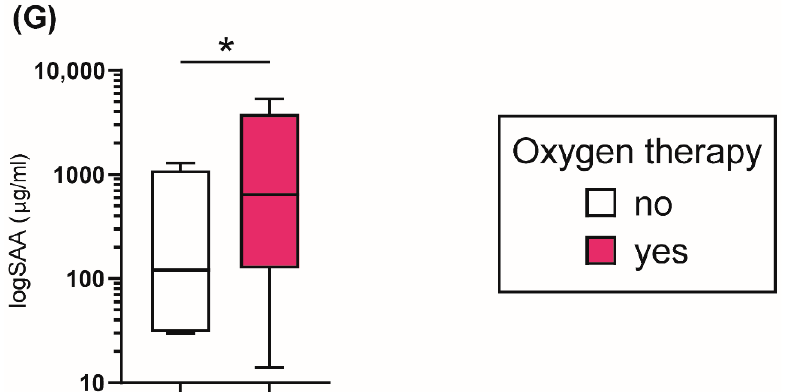
Figure 3. Tukey boxplots of HDL-related parameters in COVID-19 patients ( n = 48) stratified by different treatment options. Oxygen therapy included treatment with oxygen mask, oxygen with CPAP and mechanical ventilation. ( A ) HDL-cholesterol levels (mg/L); ( B ) LCAT activity (% substrate turnover); ( C ) Cholesterol efflux capacity (%); ( D ) arylesterase activity of PON1 (mM/min/mL serum); ( E ) anti-oxidative capacity (% reduction of oxidation); ( F ) anti-inflammatory capacity (% inhibition of NF κ B expression); ( G ) logSAA ( µ g/mL). Differences between the two groups were analyzed by the Mann–Whitney U test. Outliers are represented by black and red dots. * p < 0.05, *** p < 0.001.